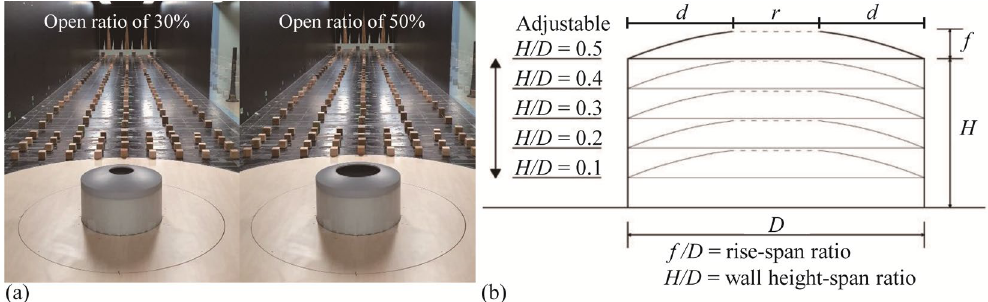
Figure 1. Photo of test model in wind tunnel and section of model: ( a ) models and ( b ) section of model. Table 1. Model dimensions.